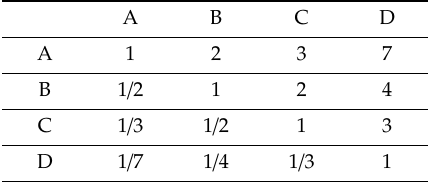
Table 6. AHP comparison matrix with five criteria.